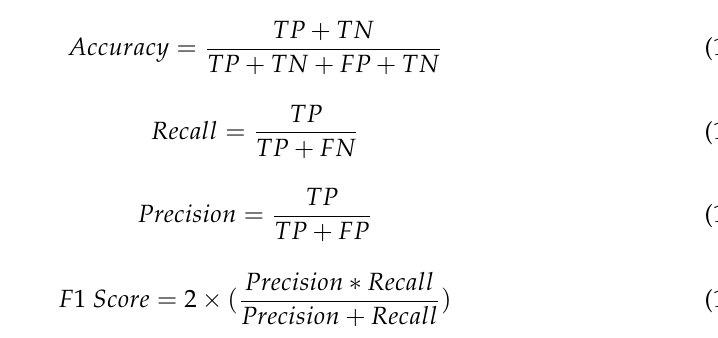
Table 2. Evaluation results of different deep learning models’ performances on the source domain.